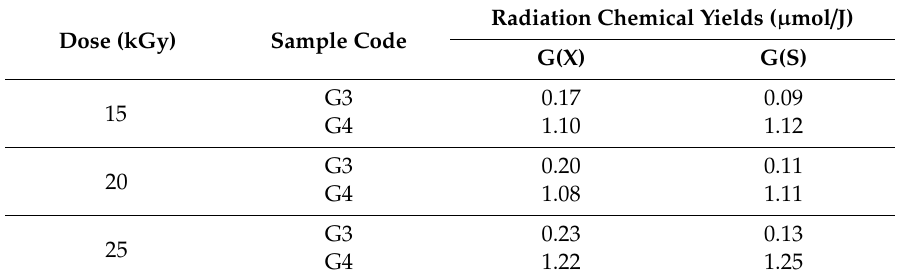
Table 2. Radiation chemical yields of crosslinking and scission of G3 and G4